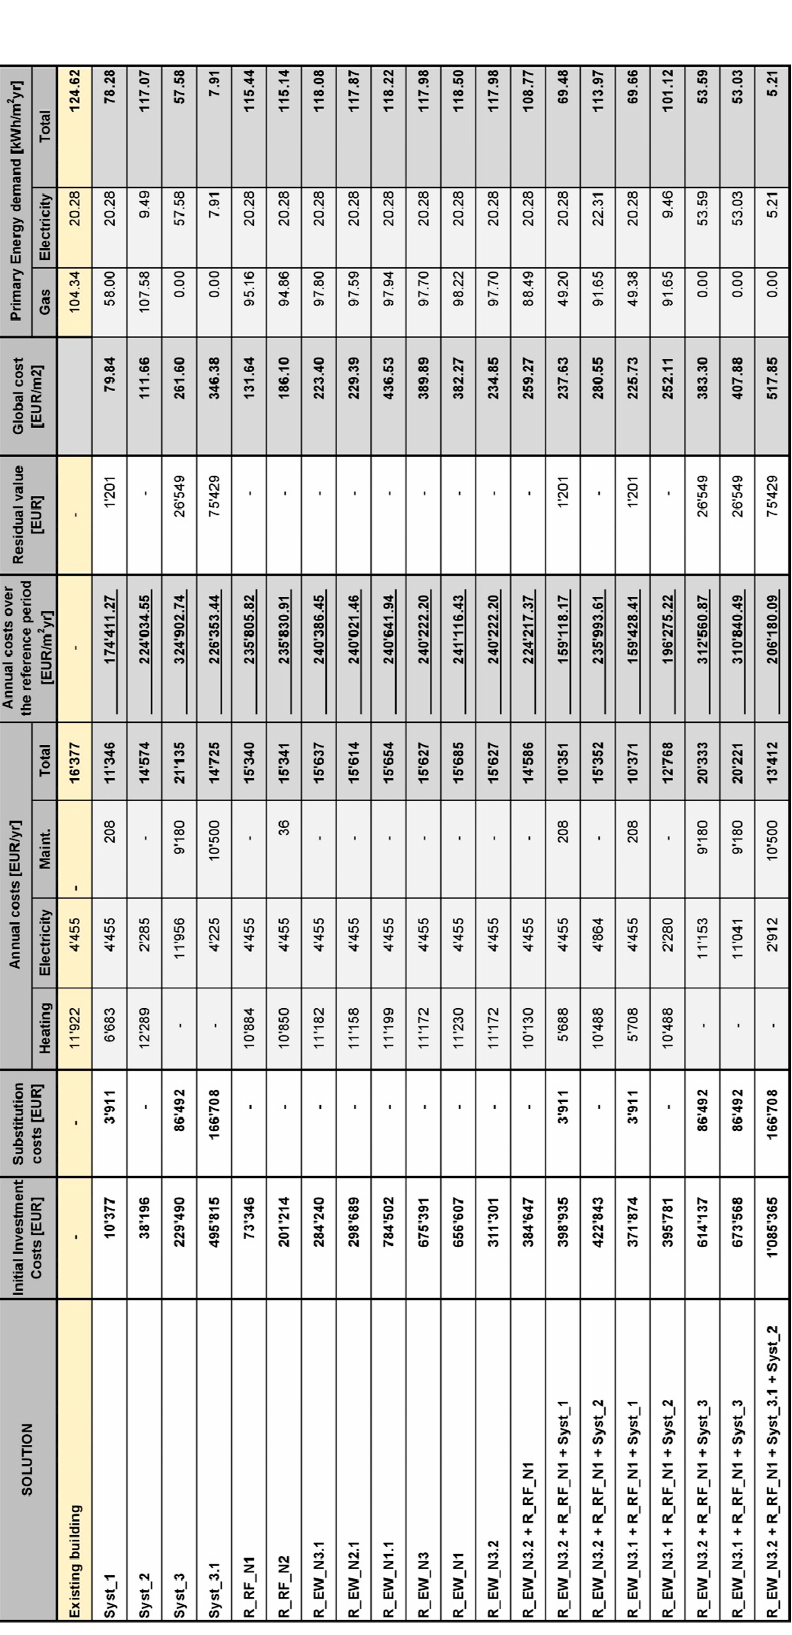
Figure A6. Summary table of cost-optimal methodology for financial scenario with discount rate equal to 5% for Rodari school.